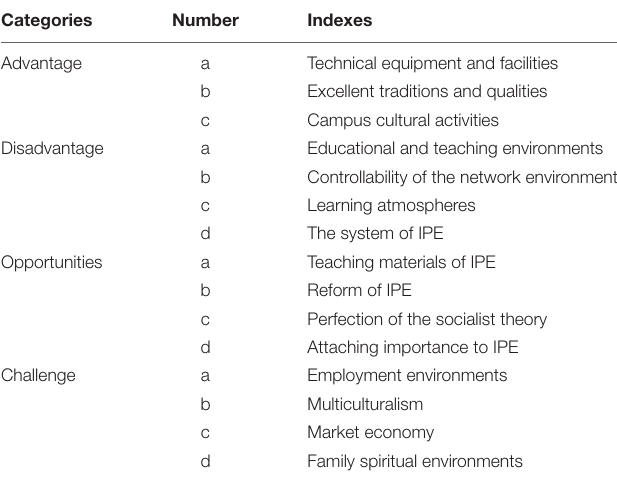
TABLE 5 | Evaluation